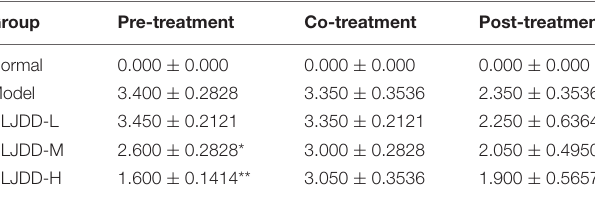
TABLE 3 | Overall histological score of jejunum of 5-Fu-treated mice. Group Pre-treatment Co-treatment Post-treatment